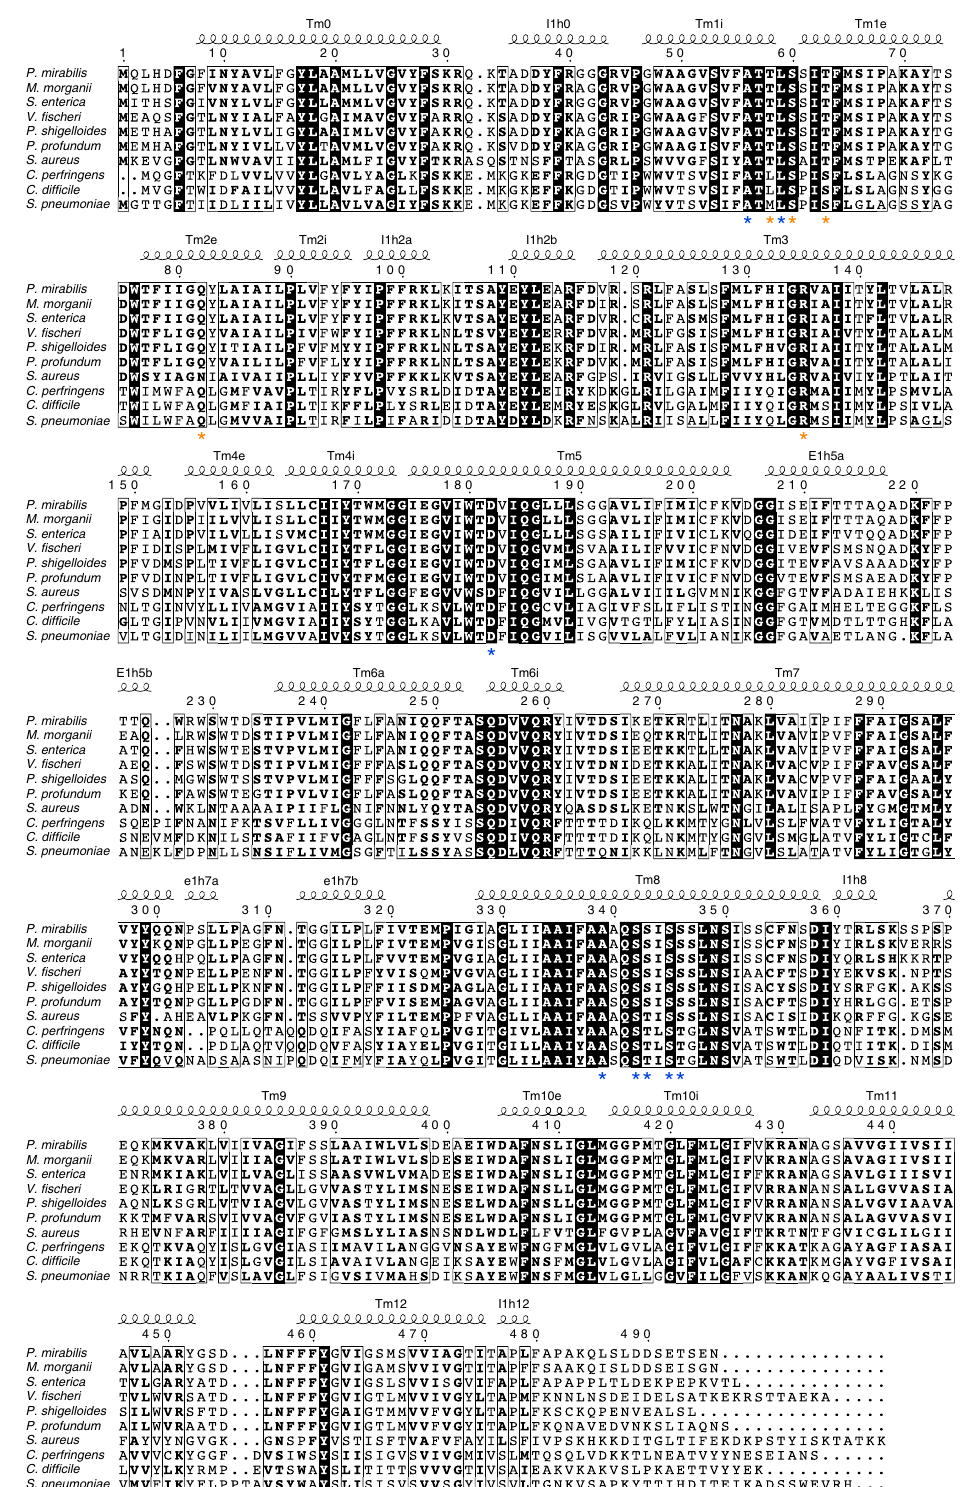
Fig. 3 Amino-acid sequence alignment and secondary structure of P. mirabilis SiaT with SiaT transporters from eight additional species of bacteria. SiaT transporters from Morganella morganii , S. enterica , Vibrio fi scheri , Plesiomonas shigelloides , Photobacterium profundum , S. aureus , C. perfringens , Clostridium dif fi cile and S. pneumoniae are aligned. Residues are numbered according to P. mirabilis SiaT, and the corresponding secondary structure of this transporter is shown above the alignment, with α -helices depicted as coils. Residues highlighted with black boxes are conserved, residues implicated in sialic acid binding are highlighted below with an orange asterisk and residues involved in sodium-binding are highlighted below with a blue